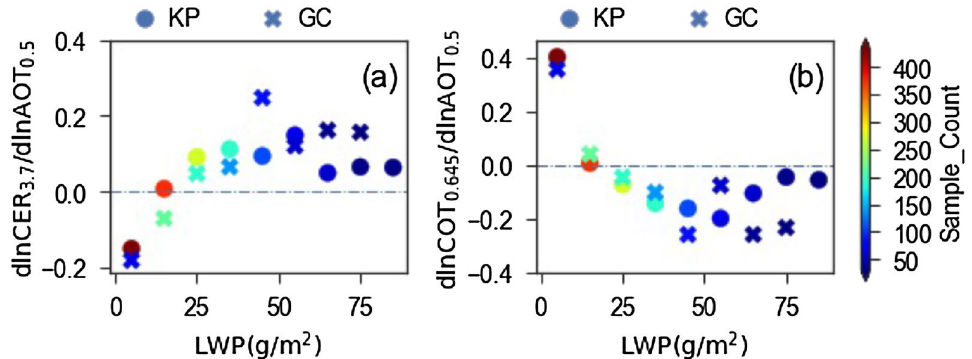
Figure 3. Values of ( a ) dlnCER 3.7 /dlnAOT 0.5 and ( b ) dlnCOT 0.645 /dlnAOT 0.5 for LWP bins of 10 g/m 2 spectrum for Kanpur (KP) and Gandhi College (GC) sites, where CER 3.7 , COT 0.645 , and AOT 0.5 are CER at 3.7 µm, COT at 0.645 µm and AOT at 0.5 µm,